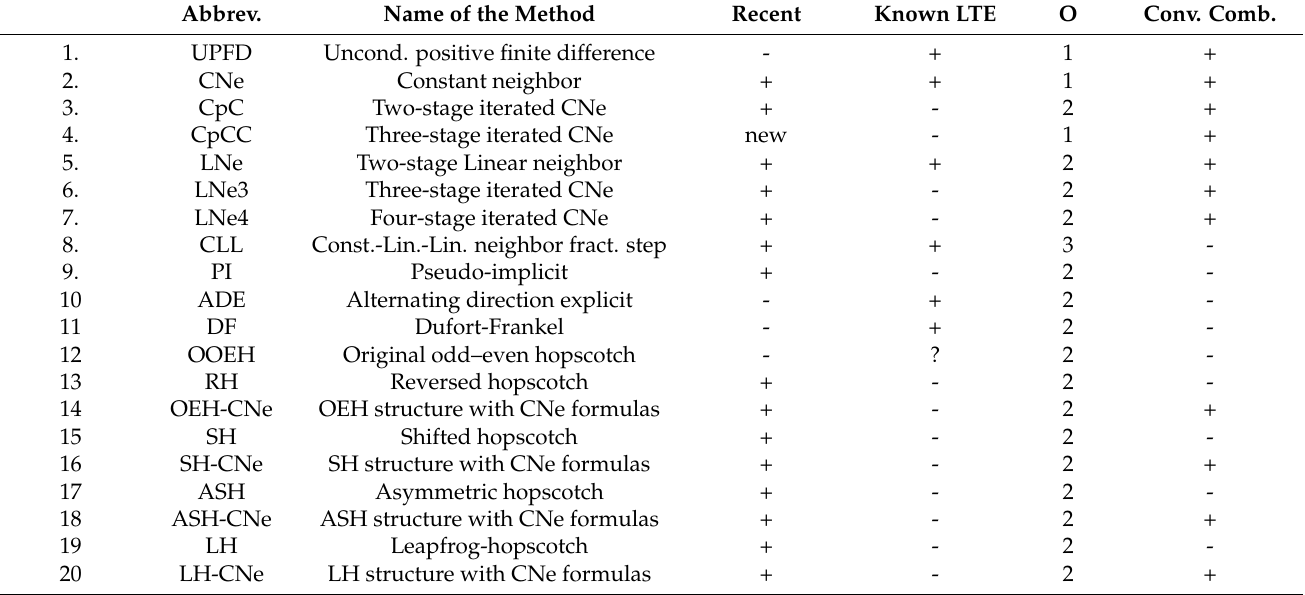
Table 1. List of the methods and their